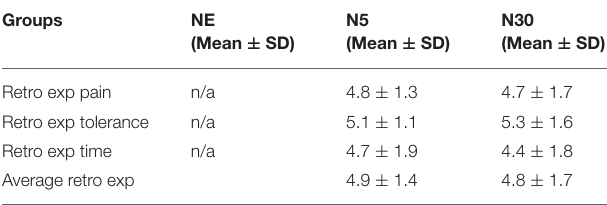
TABLE 6 | Participants’ retrospective expectations.